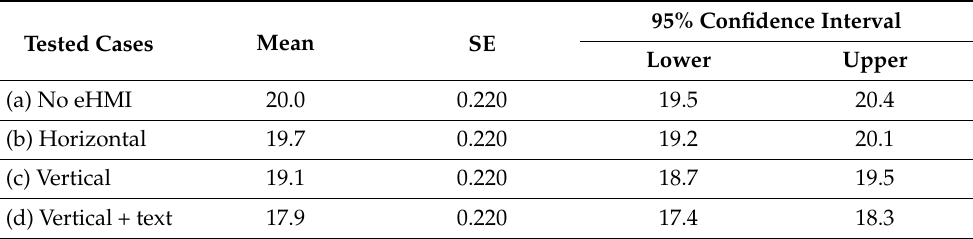
Table 4. Estimated marginal means of time until the maximum level of the willingness to stop was reached by tested cases (seconds).